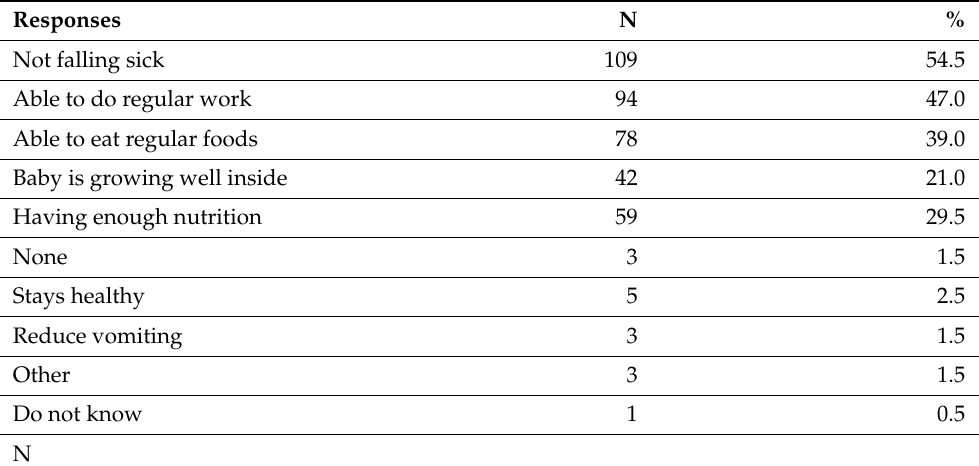
Table 5. Awareness about the benefits of taking pregnancy